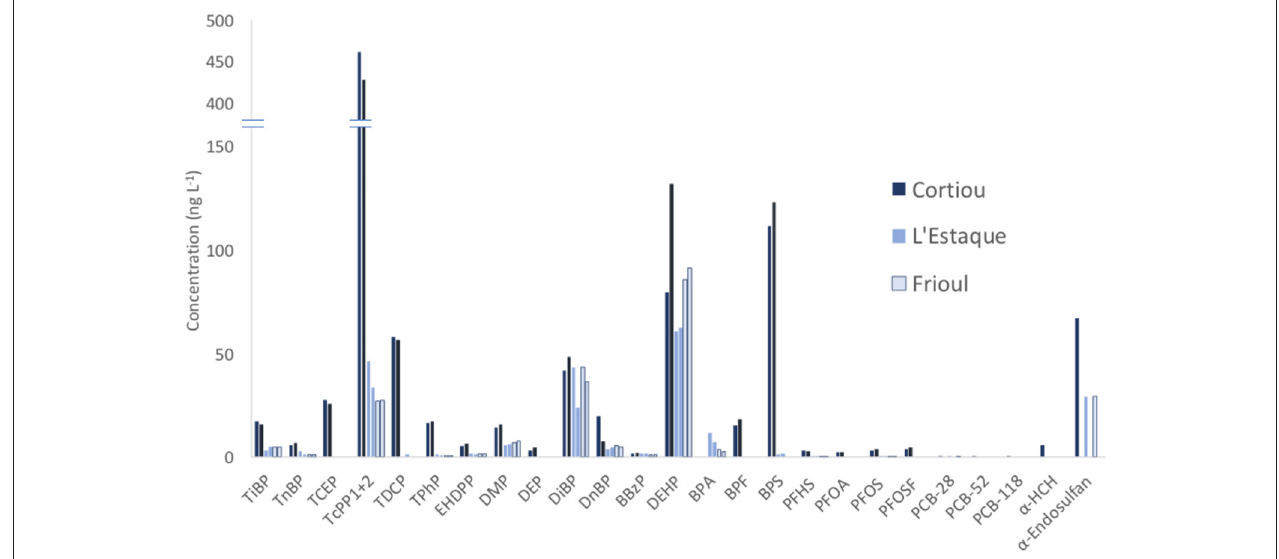
FIGURE 3 | Concentrations of contaminants found at the three sampling sites (Cortiou, L’Estaque, and Frioul) in the Bay of Marseille in May 2017. The duplicate samples are shown as two consecutive bars. The y-axis breaks between 150 and 400 ng L − 1 . Not detected compounds are not shown. OCs were analyzed on one replicate at each site. The contaminant abbreviations are given in Table 1 . Compounds are grouped by chemical family.